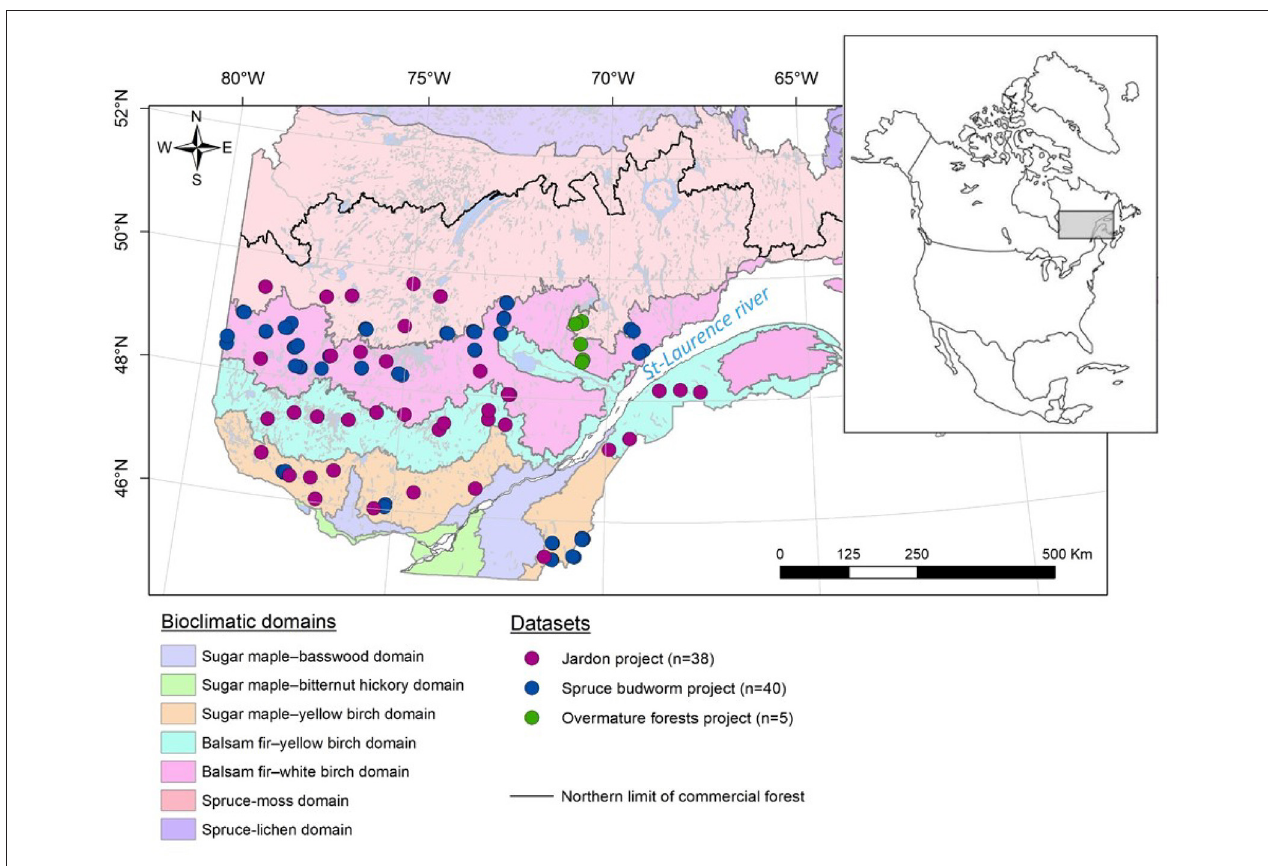
FIGURE 1 | Location of the studied forest stands in Quebec (Canada).